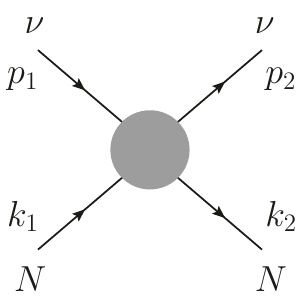
Figure 2 . The kinematics of neutrino scattering on nucleons, (cid:23) ( p 1 ) N ( k 1 )